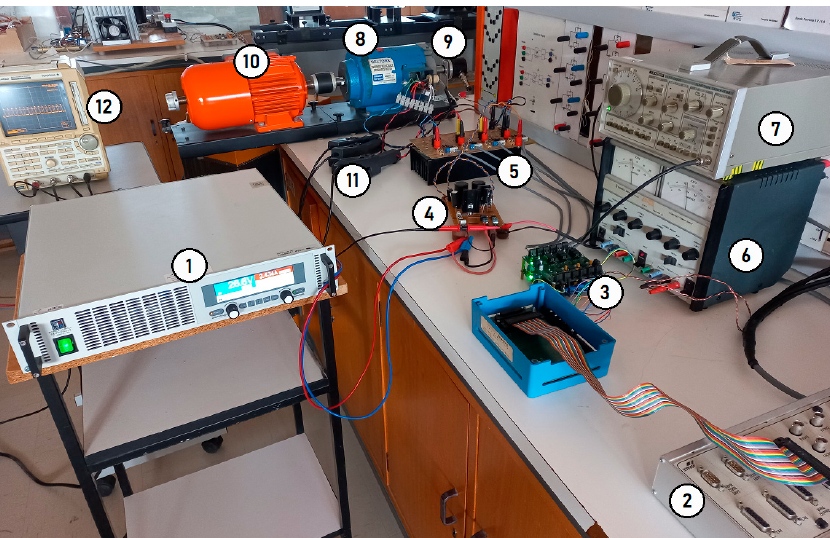
Figure 11. Photograph of the experimental test bench with the proposed laboratorial prototype: